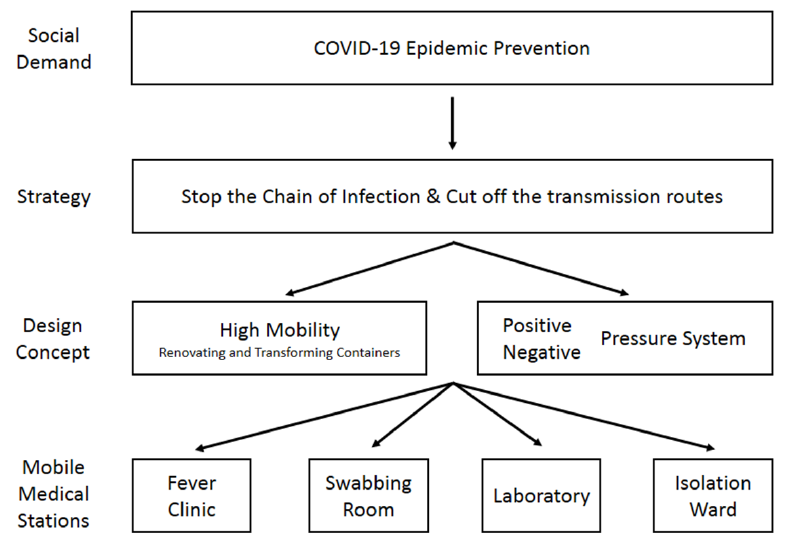
Figure 1. Concept used for the design of mobile medical stations.